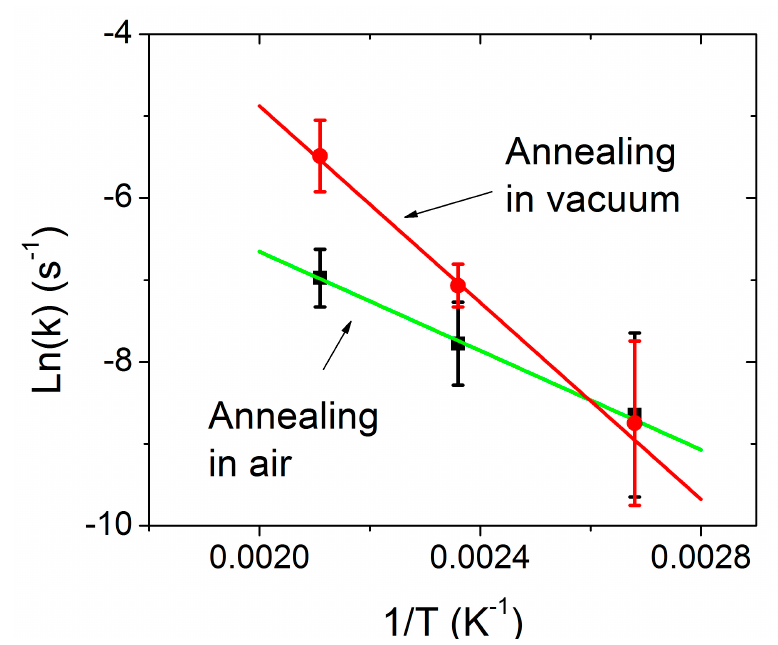
Figure 6. Arrhenius plot of the rate constant k for 1T MoS 2 samples annealed in vacuum and in air. Straight lines are a linear fit to the experimental data.